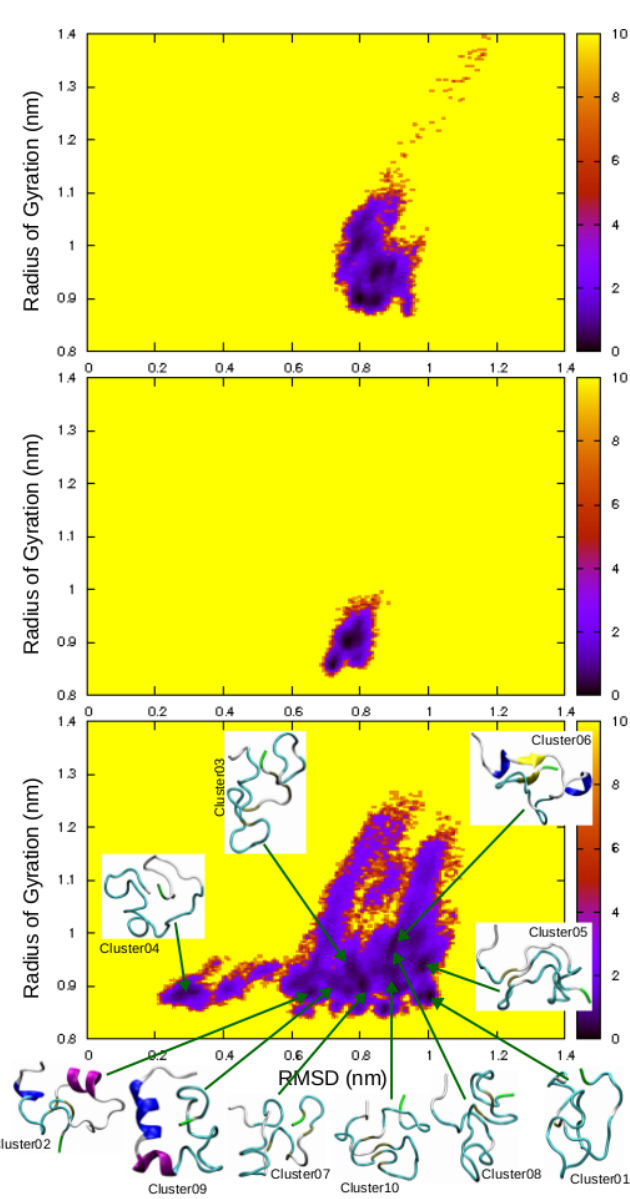
Figure 6. hIAPP free energy (kcal/mol) surfaces as a function of the RMSD relative to the initial random coil conformation and of its radius of gyration. ( Top ) MD simulation of the amidated hIAPP; ( Middle ) MD simulation of the non-amidated peptide; ( Bottom ) REMD simulations of the non-amidated